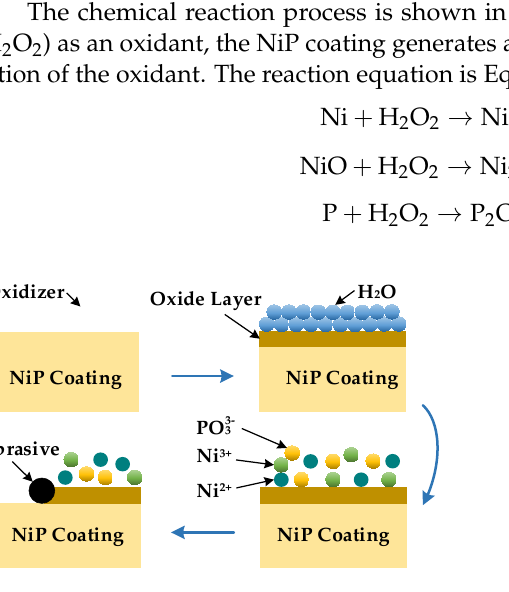
Figure 3. Schematic diagram of the chemical reaction process.